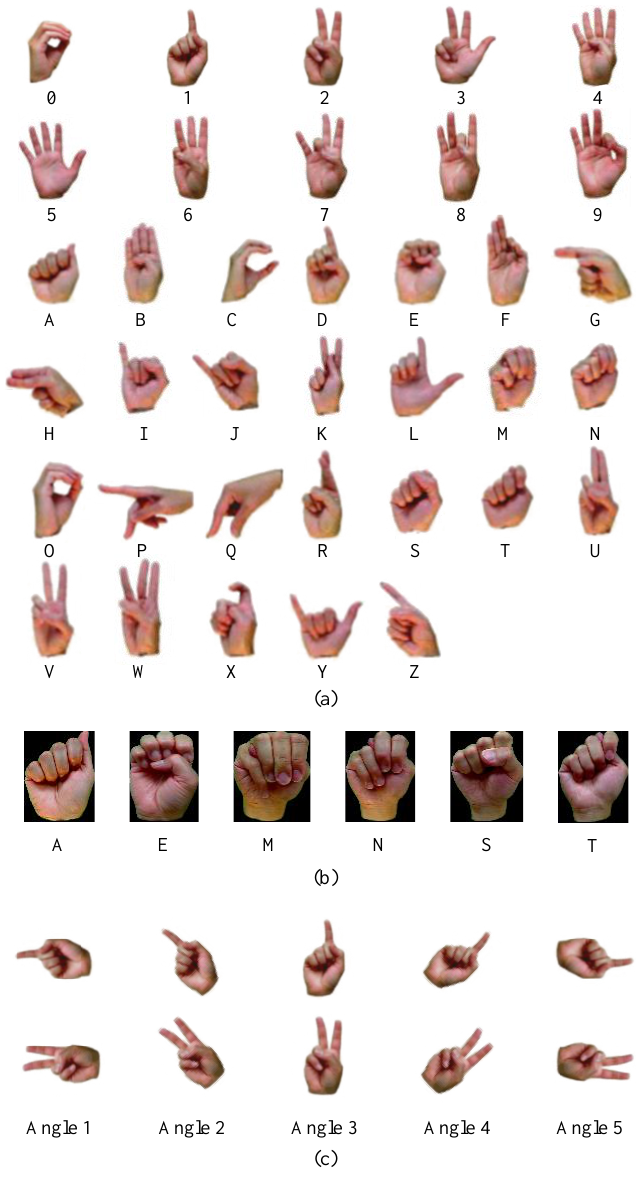
Figure 13. ( a ) Images in the MU HandImages ASL dataset. ( b ) Some similar gesture images in the MU HandImages ASL dataset. ( c ) The rotated images in five directions based on the MU HandImages ASL